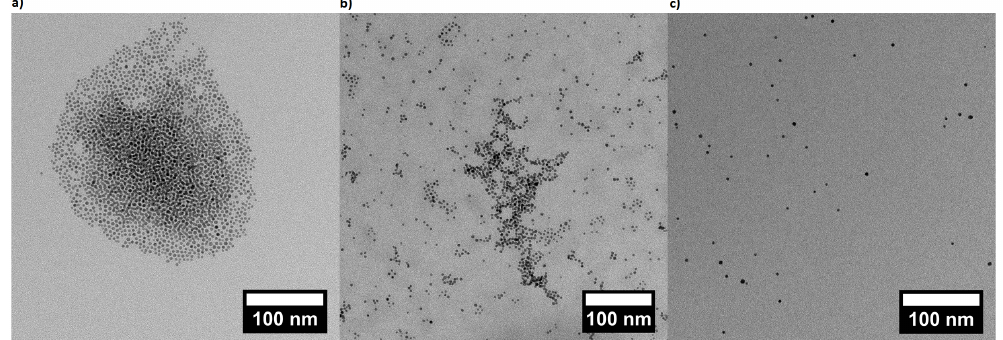
Figure 4. Transmission electron microscopy (TEM) measurements of gold nanoparticles (AuNPs) dispersed ( a ) at pH 4; ( b ) at pH 6; ( c ) at pH 8.